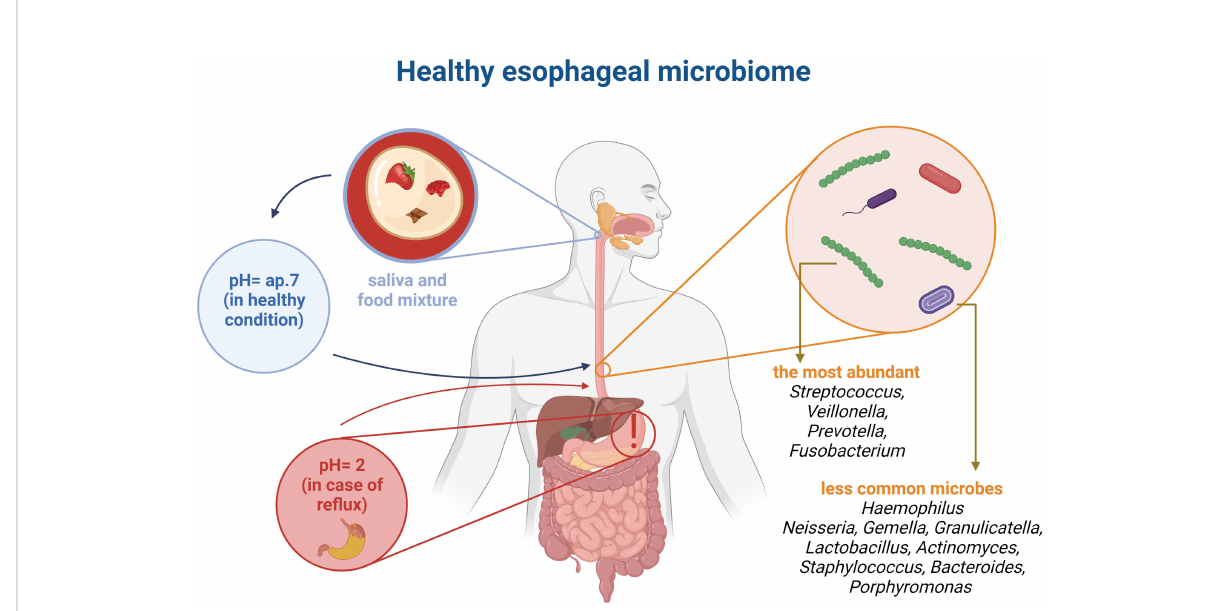
FIGURE 2 Comparison pointer value pH in healthy organism and with a re fl ux. Healthy esophageal microbiome based on literature (Di Pilato et al., 2016; Corning et al., 2018; Lv et al., 2019; Laserna-Mendieta et al., 2021). This fi gure was created using Biorender.com